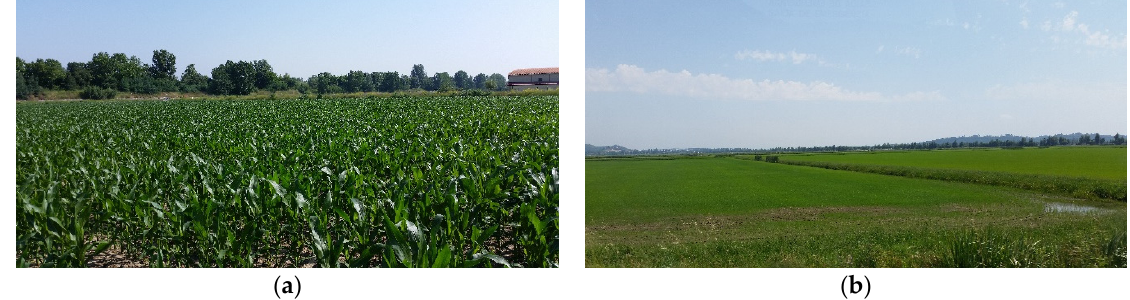
Figure 5. Maize ( a ) and rice ( b ) crops produced in the Mondego